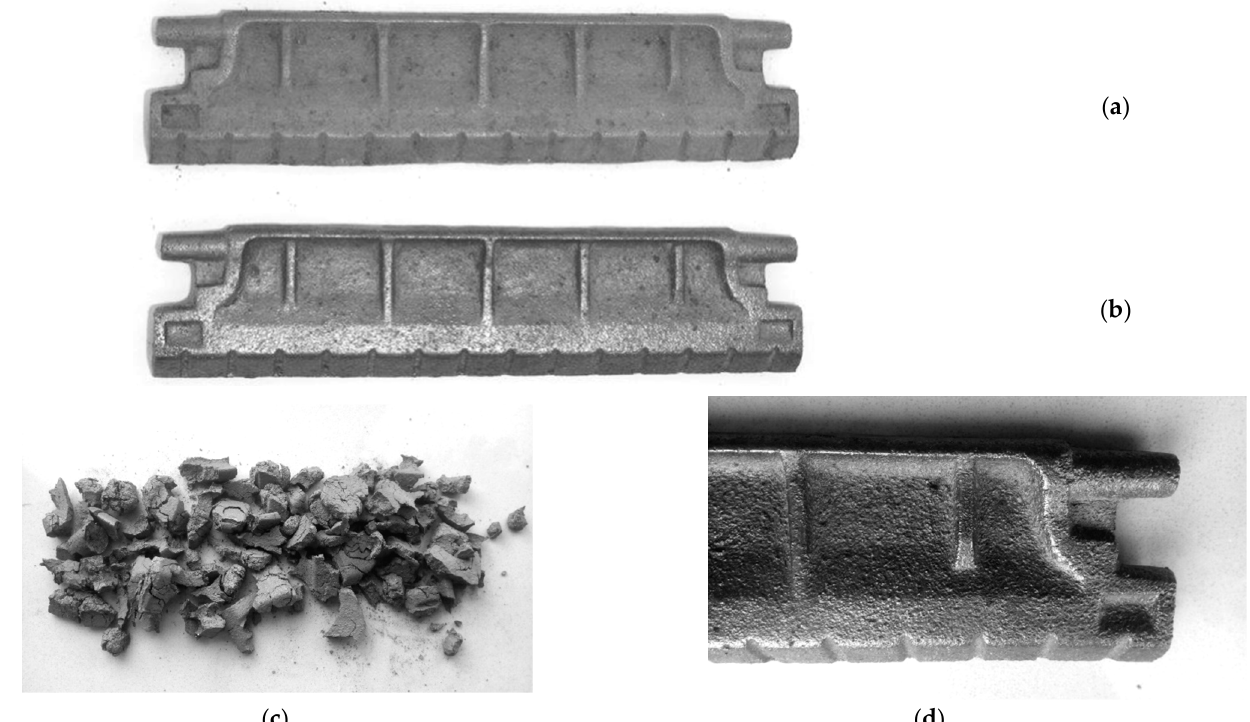
Figure 6. Photographs of high-aluminum cast iron ( a , c ) and high-aluminum cast iron castings with the addition of titanium ( b , d ). Table 1. Chemical composition of the reference cast iron.